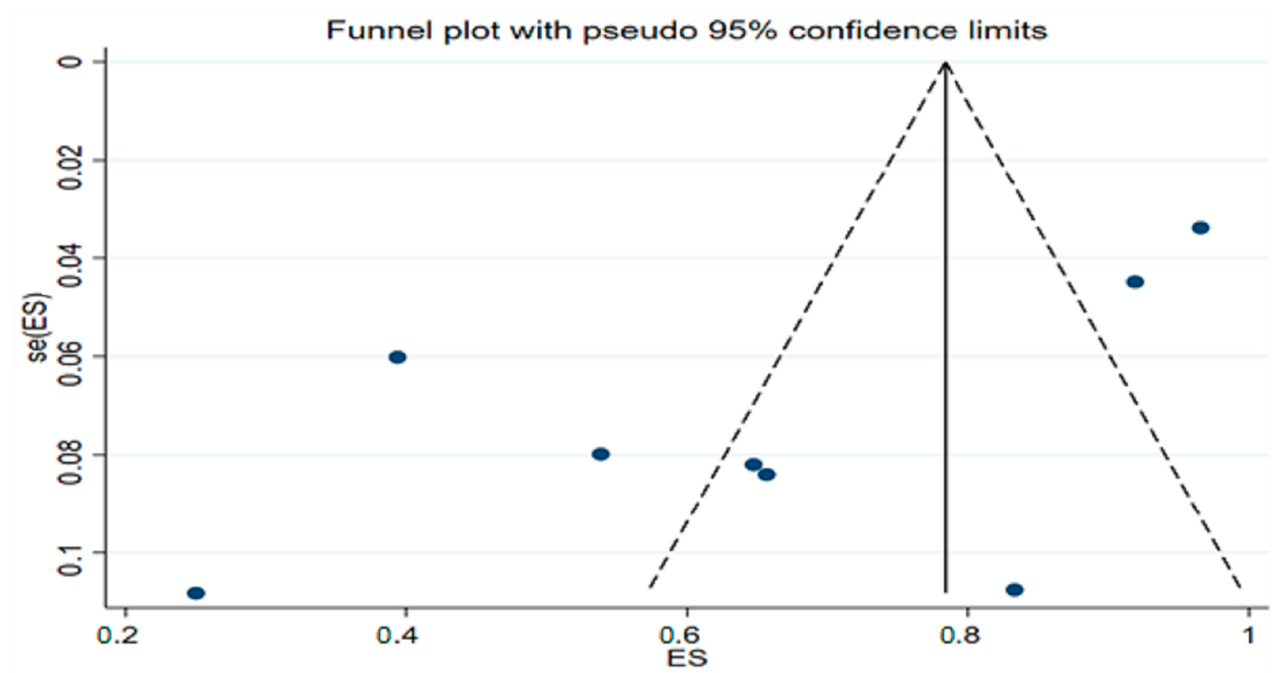
Figure 3. Funnel plot of studies used to compute pooled response rate to inhaled nitric oxide (iNO) in patients with COVID-19. ES = effect size; se (ES) = standard error of effect size.